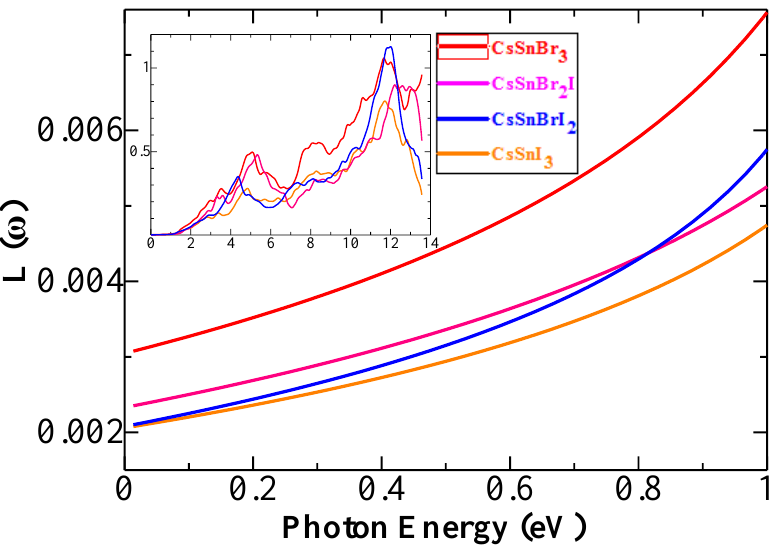
Figure 6. Calculated Energy-Loss Function for CsSnBr3, CsSnIBr2, CsSnI2Br and CsSnI3 depending on the energy (insert: L(ω) in the range from 0 to 14 eV)